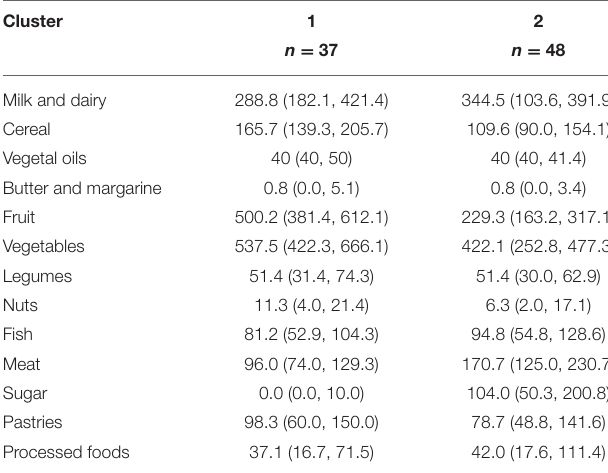
TABLE 4 | Characterization of the maternal diets ( n = 85) during pregnancy expressed in food groups and nutrients (mean g/day), according to the two clusters previously defined in the study cohort (3).